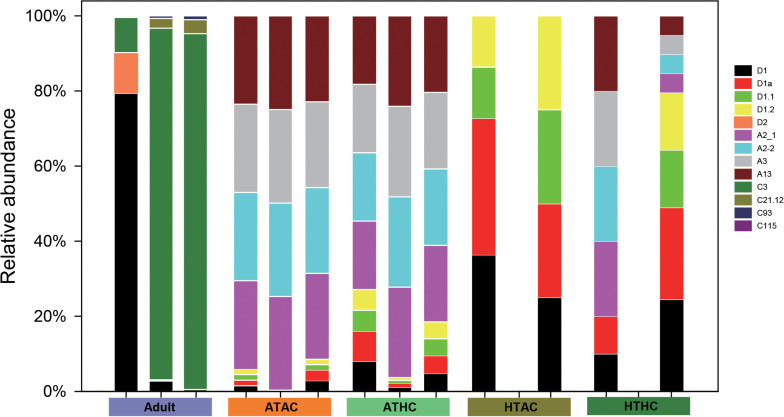
Symbiodiniaceae diversity in adult and juvenile Acropora intermedia. Adult refers to adult A. intermedia. ATAC, ATHC, HTAC, and HTHC refer to juvenile coral in four treatments: ATAC (28°C and pCO2 ∼600 μatm), ATHC (28°C and pCO2 ∼1,200 μatm), HTAC (30.5°C and pCO2 ∼600 μatm), and HTHC (30.5°C and pCO2 ∼1,200 μatm). Three replicates per treatment. Symbionts were not detected in one replicate of HTAC and HTHC treatments.